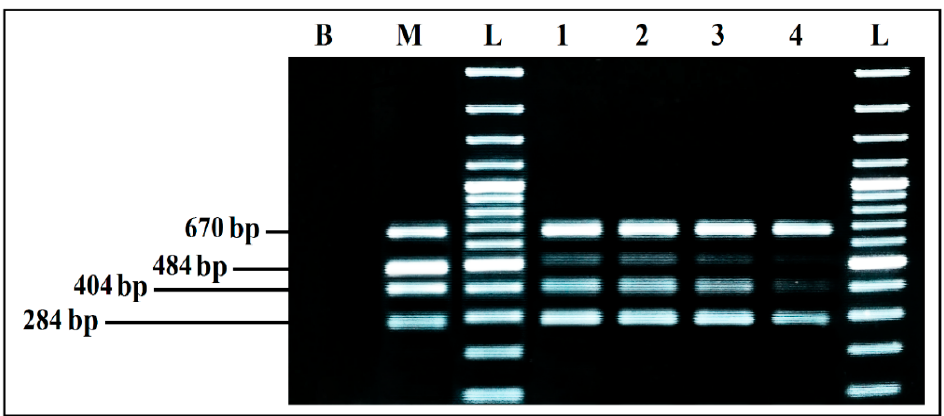
Figure 7. mPCR detection, from co ‐ cultures in BPW. B, negative control; M, mPCR positive control; L, 100 bp DNA ladder; lane 1, mPCR results from co ‐ culture in BPW initially inoculated at 10 3 CFU/mL; lane 2, mPCR results from co ‐ culture in BPW initially inoculated at 10 2 CFU/mL; lane 3, mPCR results from co ‐ culture in BPW initially inoculated at 10 1 CFU/mL; lane 4, mPCR results from co ‐ culture in BPW initially inoculated at 10 0 CFU/mL; L, 100 bp DNA ladder.